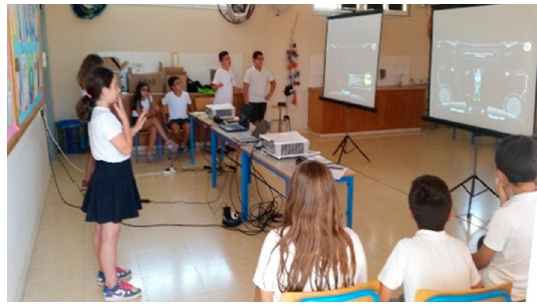
Figure 2. Two groups in the high-embodied condition.